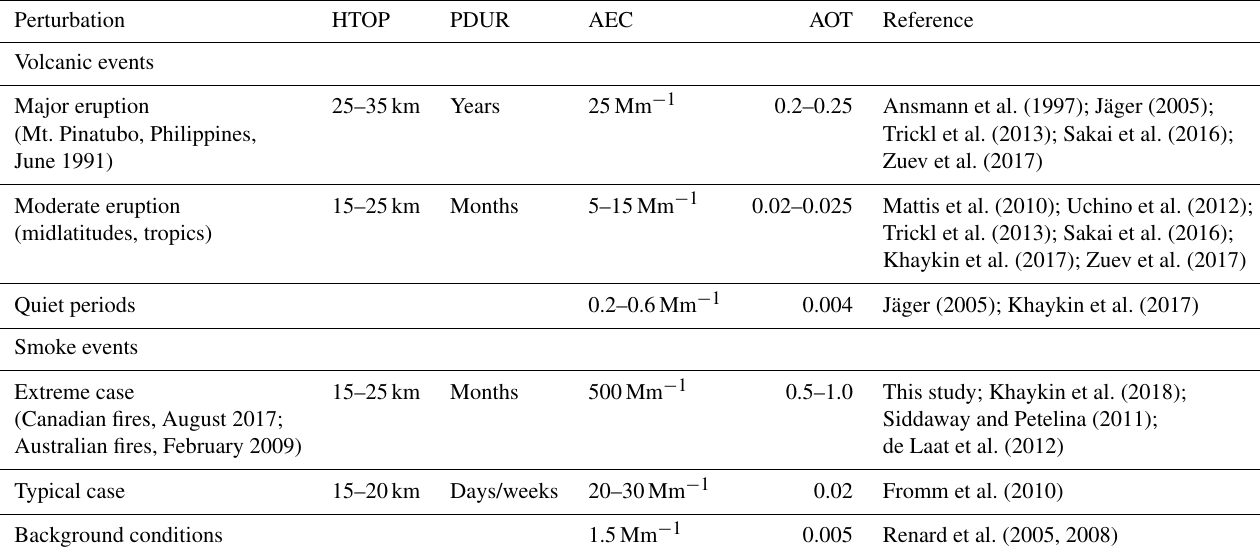
Table 1. Comparison of extreme and moderate events of stratospheric aerosol perturbations (volcanic eruptions and pyrocumulonimbus- related smoke events) as observed using lidar over northern midlatitudes. Characteristic values for maximum layer top height (HTOP), typical observable duration of the stratospheric aerosol perturbation (PDUR), maximum 532nm aerosol extinction coefficient (AEC), and AOT (above the tropopause) are given. For background aerosol conditions, mean AEC and AOT values are shown. The extraordinarily strong (“Black Saturday”) wildfire smoke event in Australia is included in the comparison. Balloon-borne in situ observations are also considered (smoke events, background conditions). More explanations are given in Sect.